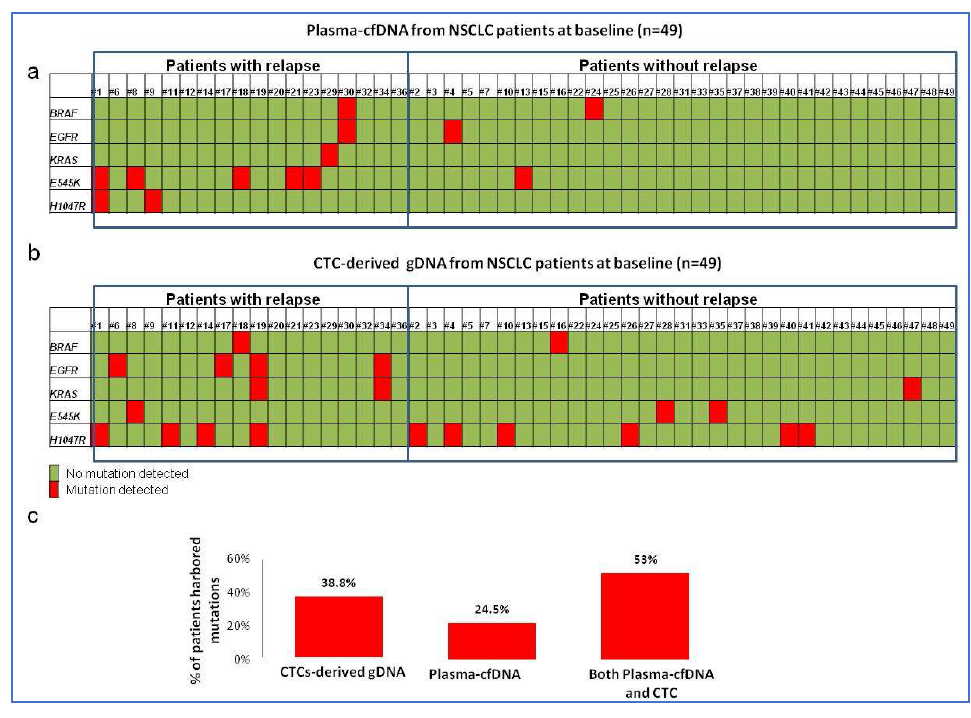
Figure 2. Mutational status of selected genes in ( a ) CTC-derived DNA of early-stage NSCLC patients ( n = 49); ( b ) plasma-ctDNA of early-stage NSCLC patients ( n = 49); and ( c ) the percentage of patients exhibiting mutations using plasma-ctDNA and CTC-derived DNA, or by analysis of plasma-ctDNA and CTCs together.The red color represents the mutation, while the green color represents WT.